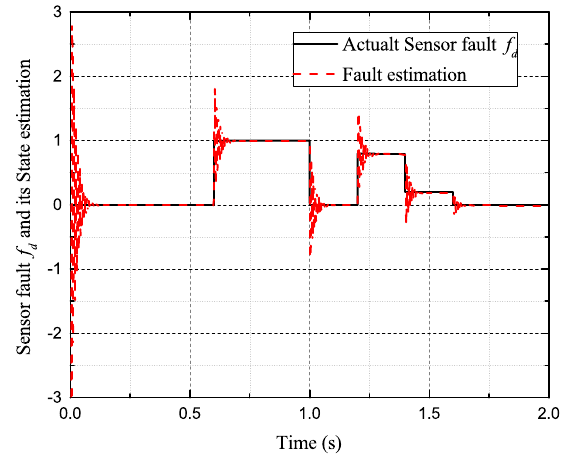
Figure 13. Sensor fault f d and its estimated value ˆ f d .